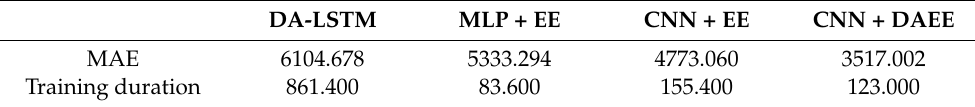
Table 10. Mean training duration and MAE in units of minutes across five iterations of CV.